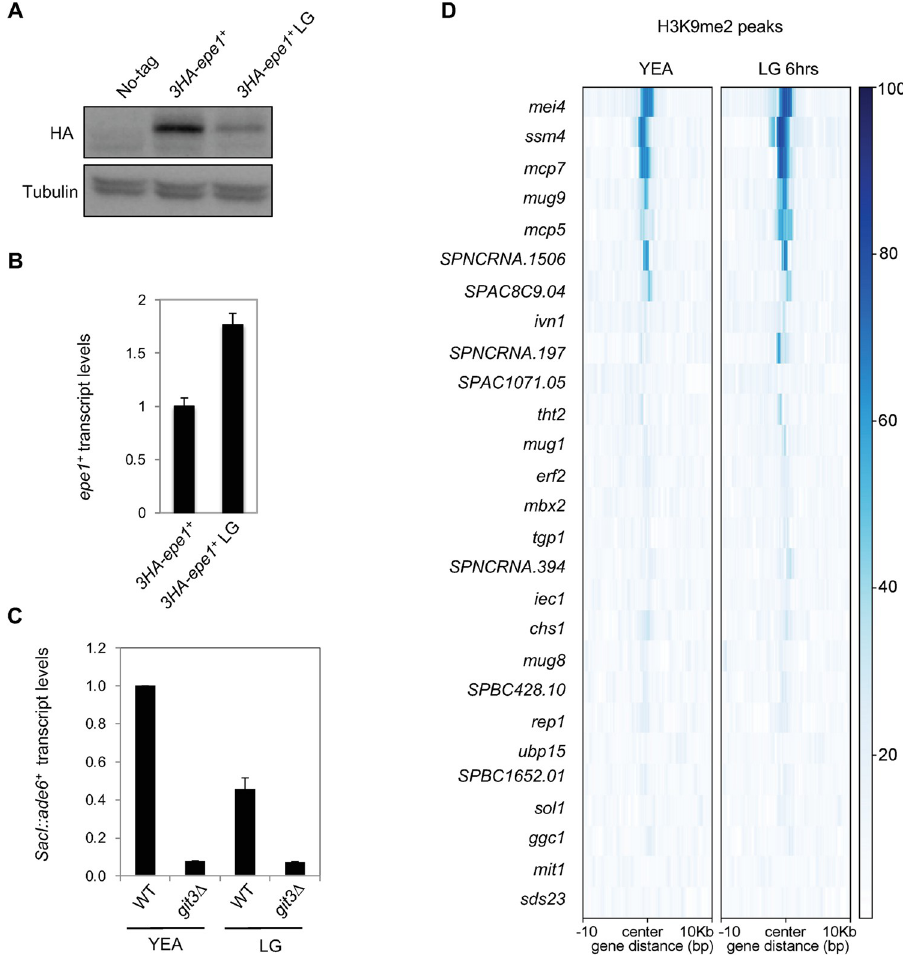
Fig 6. Extracellular glucose concentration affects Epe1 protein levels and heterochromatin formation. (A) Western blot analysis to measure the levels of 3HA-tagged Epe1 and tubulin. Cells were shifted to a low-glucose medium (LG) for 6 hours before protein extraction. (B) RT-qPCR analysis of epe1 + transcript levels, normalized to act1 + . Error bars represent SD, n = 2. (C) RT-qPCR analysis of ade6 + transcript, normalized to act1 + . Error bars represent SD, n = 2. (D) Heatmap of H3K9me2 levels at individual heterochromatin islands.